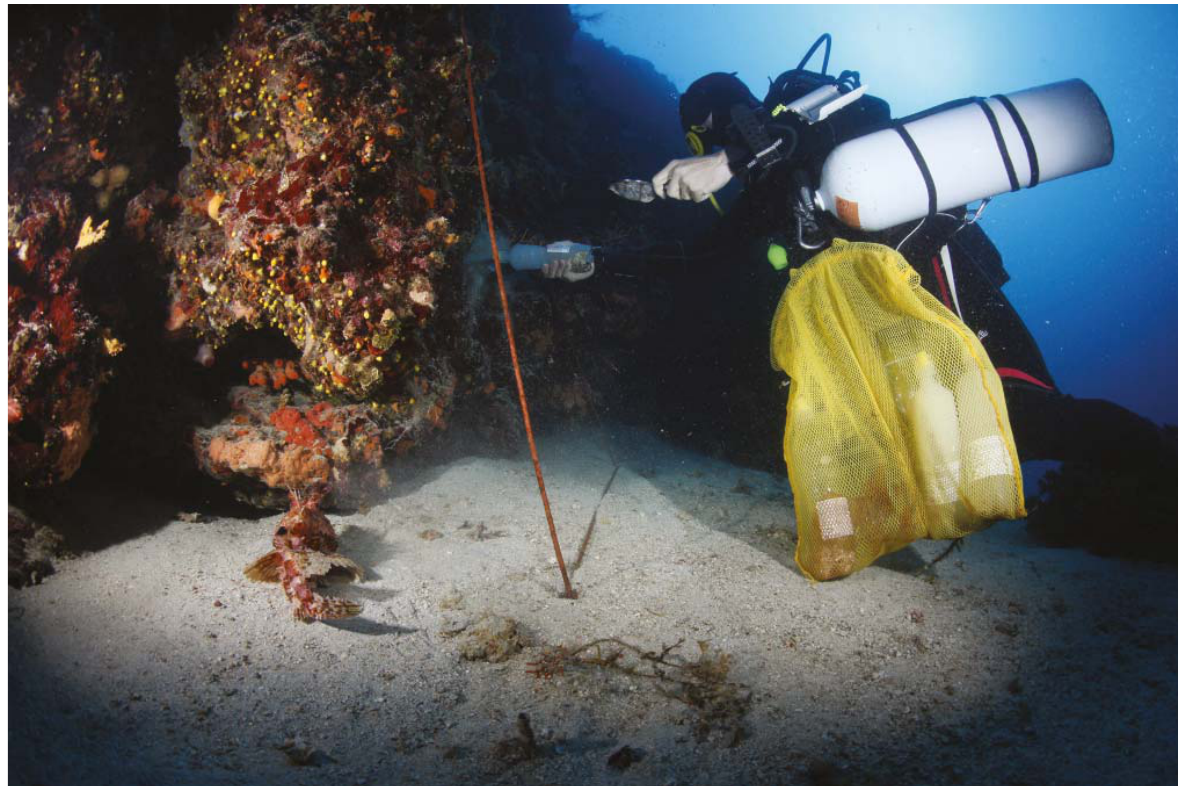
Fig. 1. Collecting within an iron bar quadrat with anaesthetics and small scoop net, depth 58 m, locality Smočiguzica; Photo by Dani